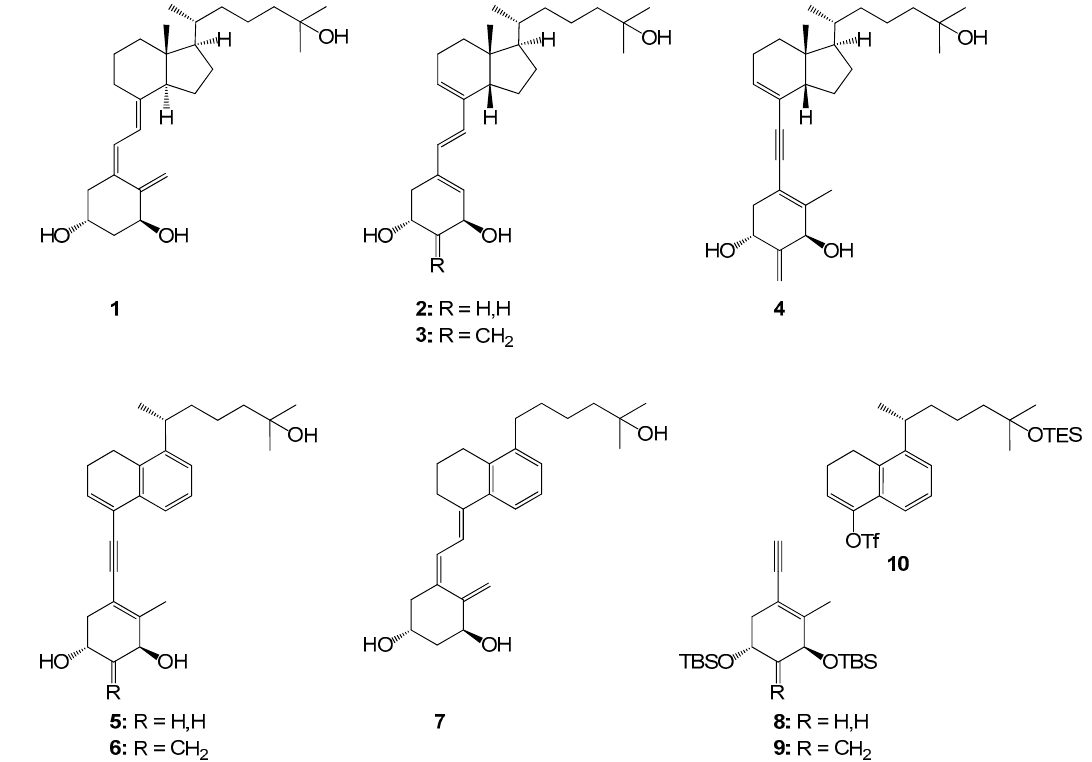
Figure 1. Chemical structure of 1 α ,25-dihydroxyvitamin D 3 ( 1 ), its analogs, and the building blocks for the synthesis of compounds 5 and 6 .